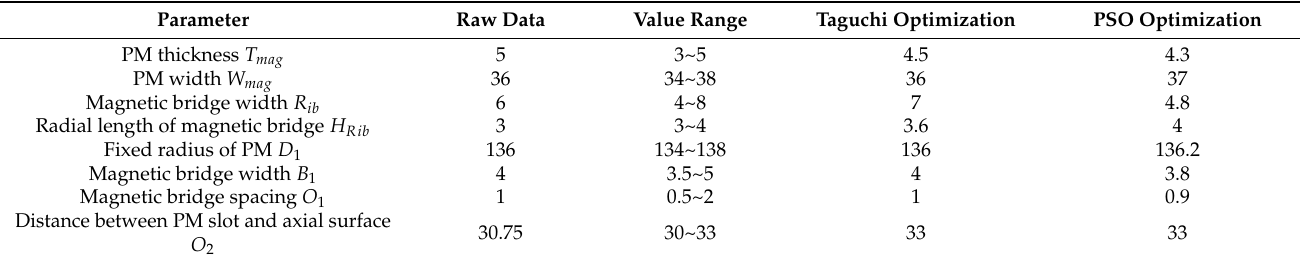
Table 5. Comparison of optimization parameters.